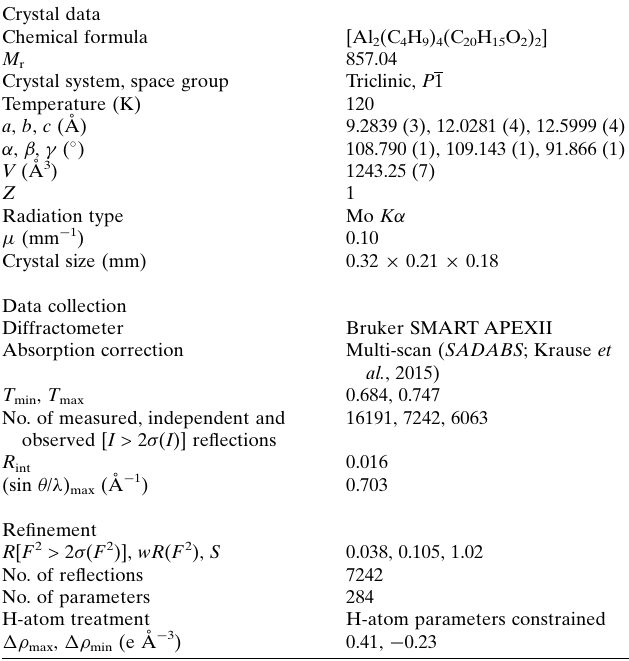
Table 2 Experimental